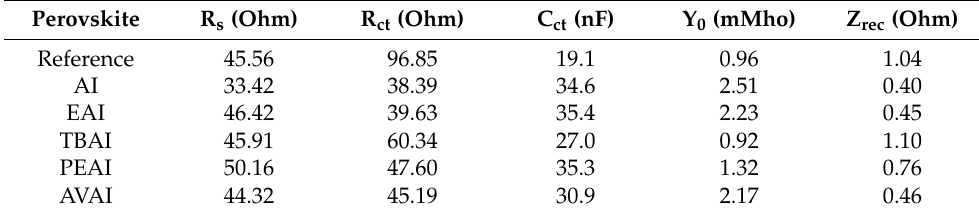
Figure 14. ( a ) Nyquist plots and ( b ) Bode phase plots obtained from Electrochemical Impedance Spectroscopy (EIS) measurements performed on the C-PSCs under study. Table 7. The electrical parameters obtained after fitting of the experimental data of the as-prepared devices’ Nyquist